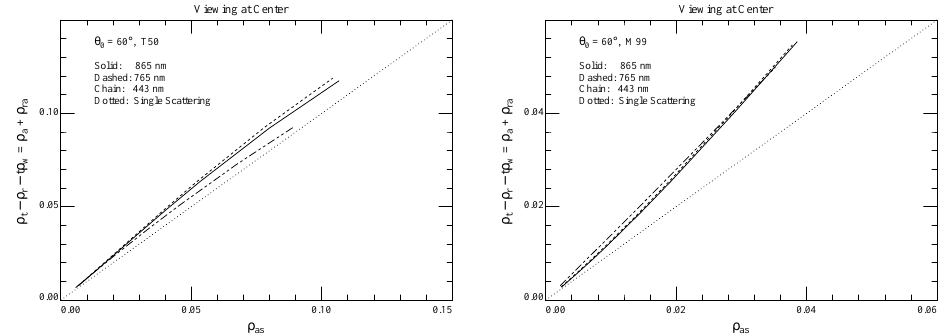
Figure 6. The ρ a ( λ ) + ρ ra ( λ ) versus ρ as ( λ ) relationship at θ 0 = 60deg and near-nadir viewing. ( Left panel ): T50. ( Right panel ): M99. From Gordon